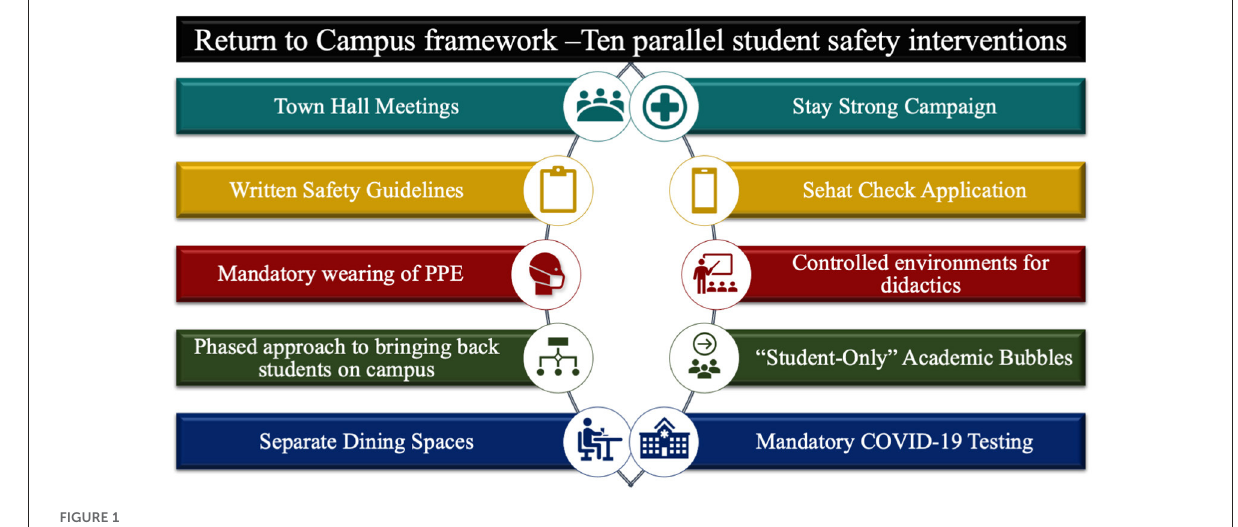
FIGURE1 Ten parallel student safety